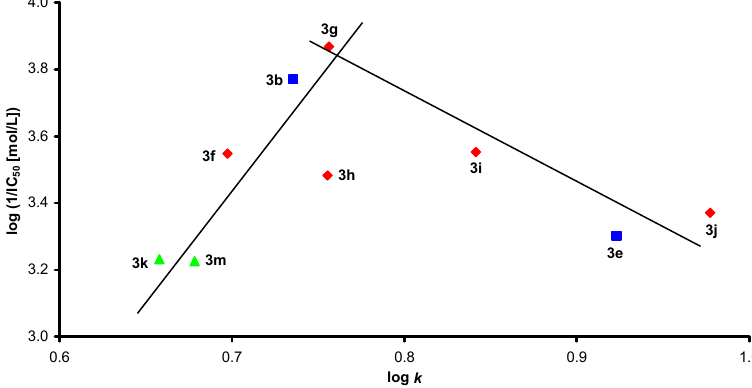
Figure 3. Relationships between PET inhibition log (1/IC chloroplasts and lipophilicity of studied benzylidenethiosemicarbazones 3a – o .